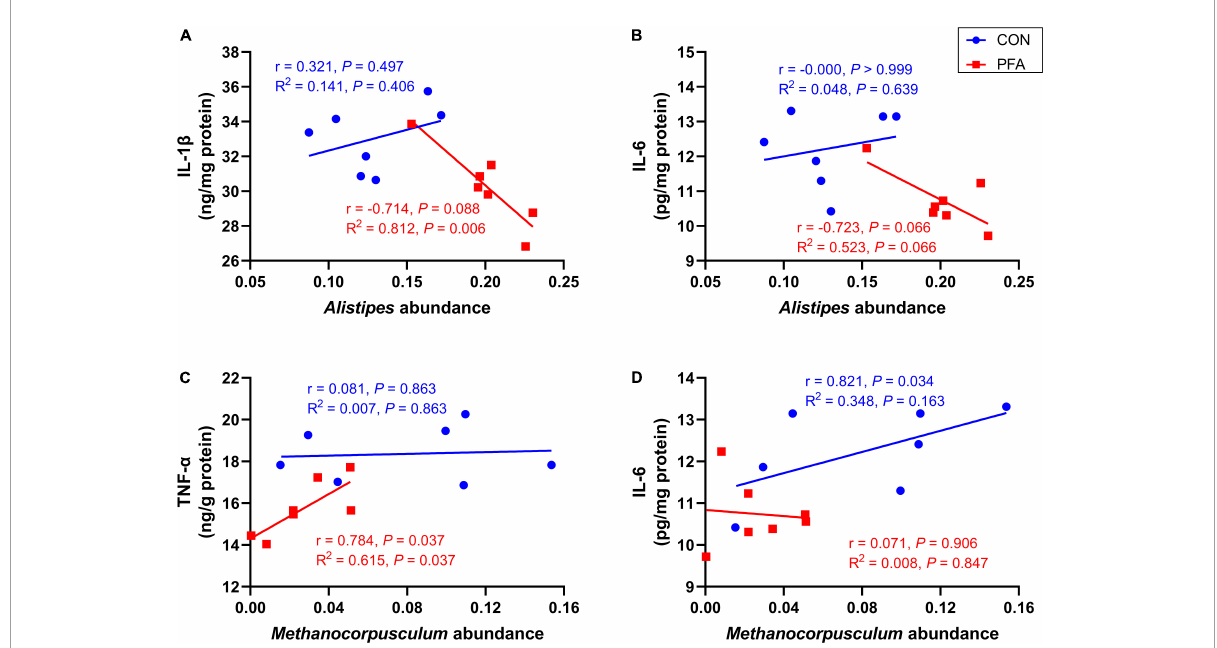
FIGURE6 Correlation analysis between Alistipes and Methanocorpusculum abundances and mucosal immunological markers concentrations. (A,B) Correlation analysis between Alistipes and interleukin-1beta (IL-1 β ) and interleukin-6 (IL-6) for CON group and PFA group; (C,D) Correlation analysis between Methanocorpusculum and tumor necrosis factor-alpha (TNF- α ) and IL-6 for CON group and PFA group. Correlation analysis was based on Spearman’s test and simple linear regression. Statistical significance was set at P < 0.05, n =